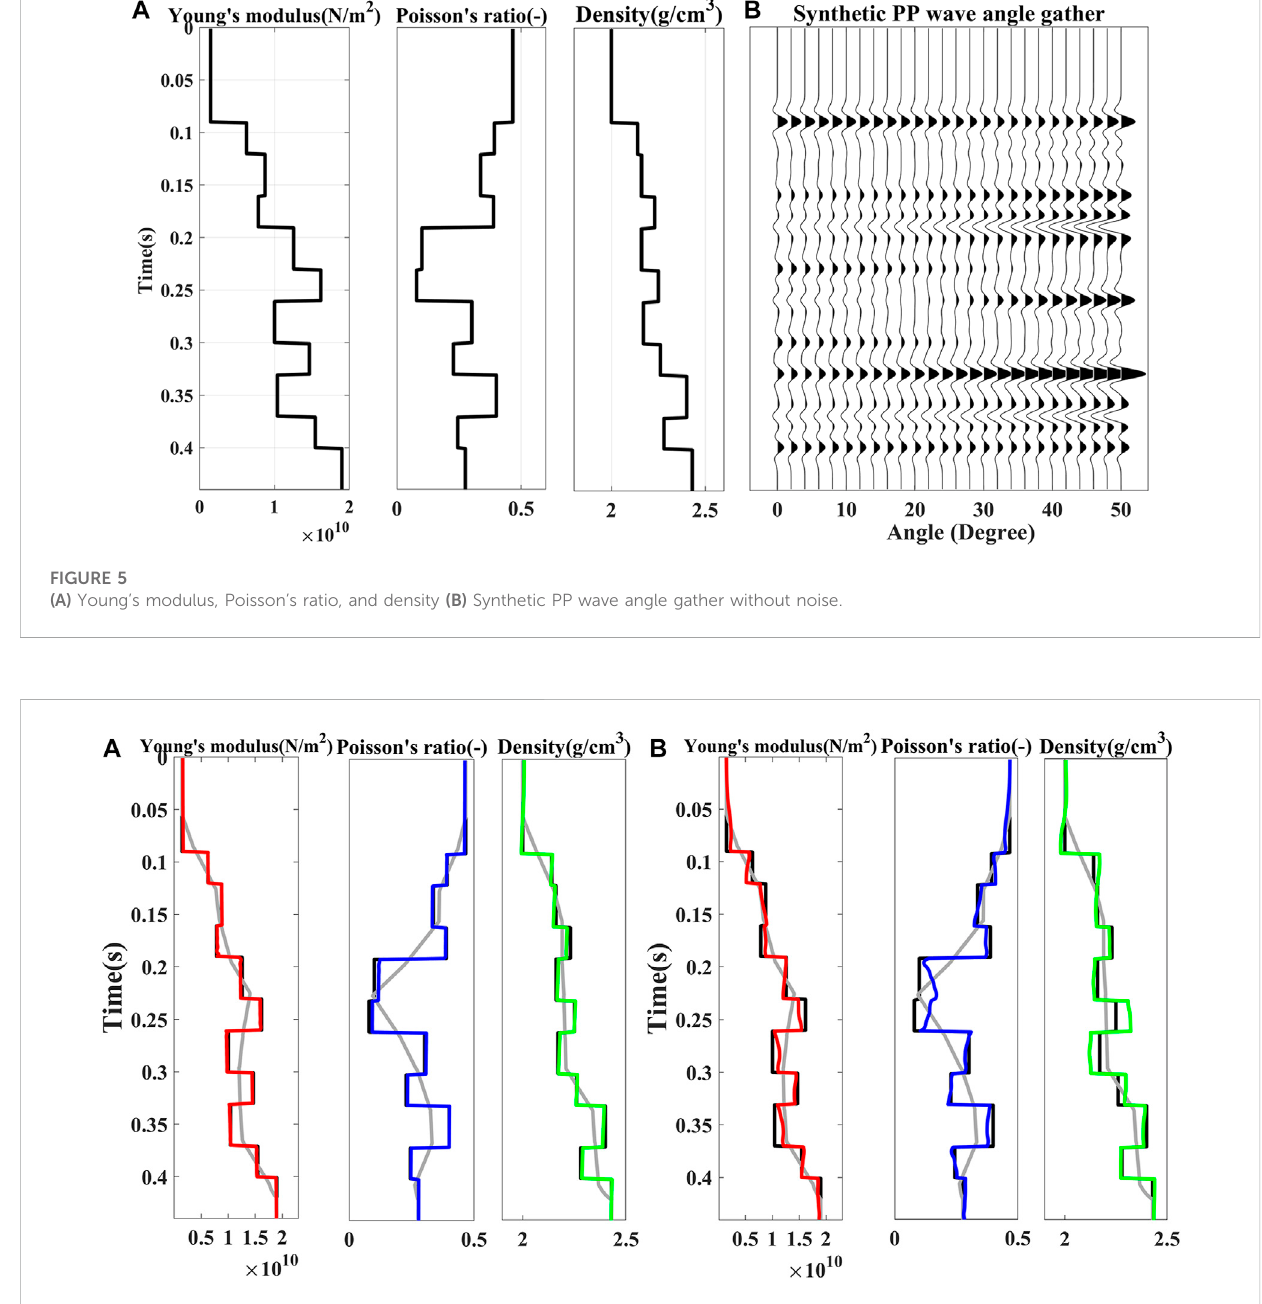
FIGURE 6 Young ’ s modulus (red), Poisson ’ s ratio (blue), and density (green) of (A) direct inversion results and (B) indirect calculated results without noise. The black lines and gray lines are the true and initial models